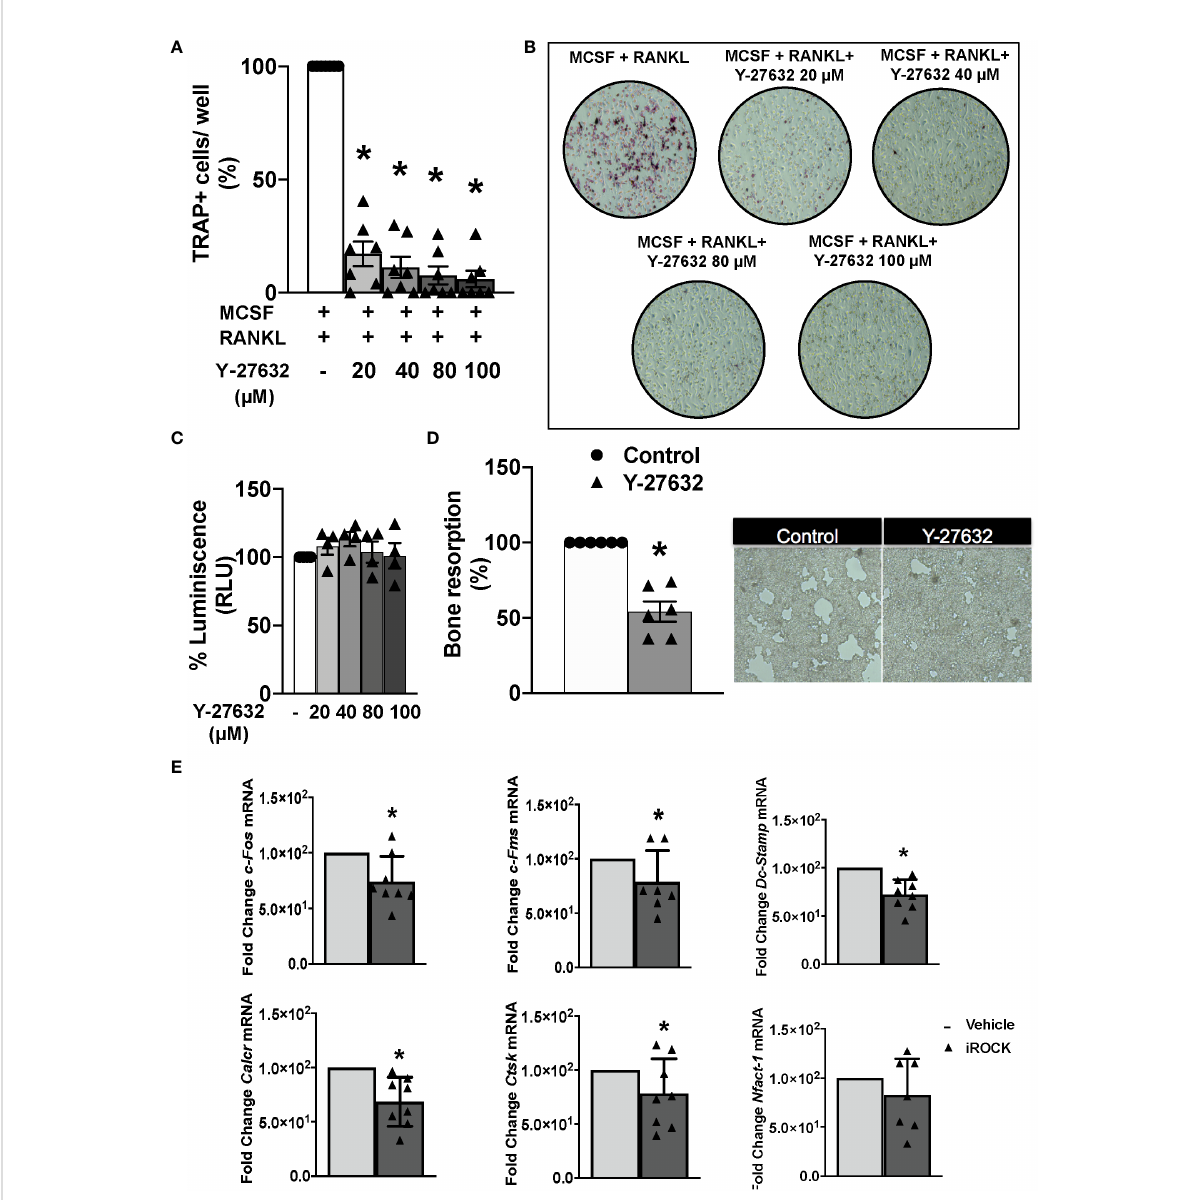
FIGURE 5 Inhibition of ROCK with Y-27632 prevents osteoclast differentiation and bone resorption in mice. (A) Percentage of TRAP+ multinucleated cells differentiated from bone marrow (BM) precursors of arthritic mice in the presence of MCSF and RANKL for 8 days and the indicated concentrations of the ROCK inhibitor Y-27632. Positive control was considered 100%. (B) Representative images of TRAP+ cells. (C) Cell viability of BM precursors treated for 8 days with the indicated concentrations, determined using the Cell Titer-Glo luminescent assay kit. Obtained luminescence for positive control was considered 100%. (D) Carbonate apatite resorption area produced by differentiated osteoclasts and representative images. Resorption produced by control group was considered 100%. (E) Gene expression of c-Fos, c-Fms, Dc-Stamp, Calcr, Ctsk and Nfatc-1 in BM precursors differentiated to osteoclasts following the same protocol as in A and quanti fi ed by real-time PCR. Values are the mean ± SEM of cells from 7 arthritic mice in (A) , 4 in (C) , 6 in (D) and 7-8 in (E) . *p < 0.05 (Wilcoxon